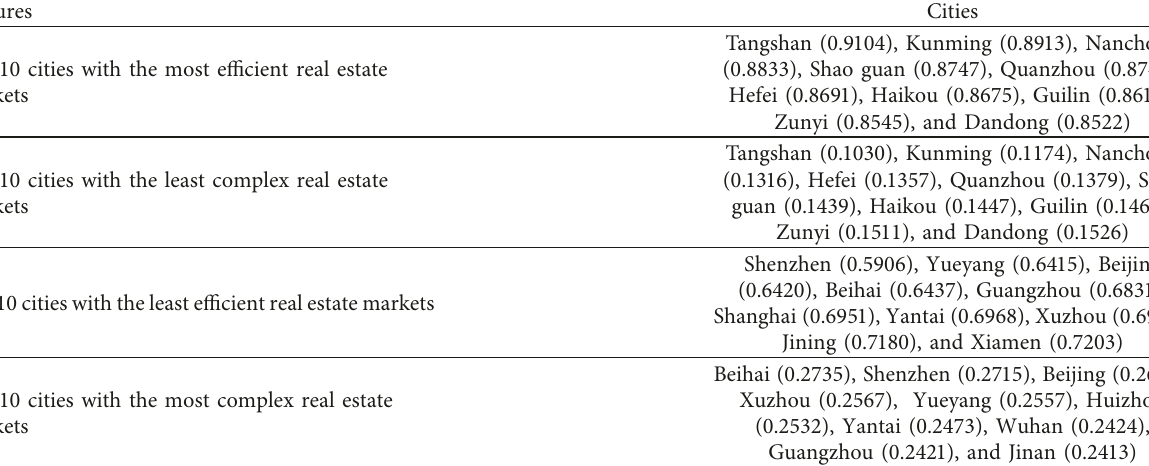
Table 3: Top 10 cities in four extreme cases in Chinese